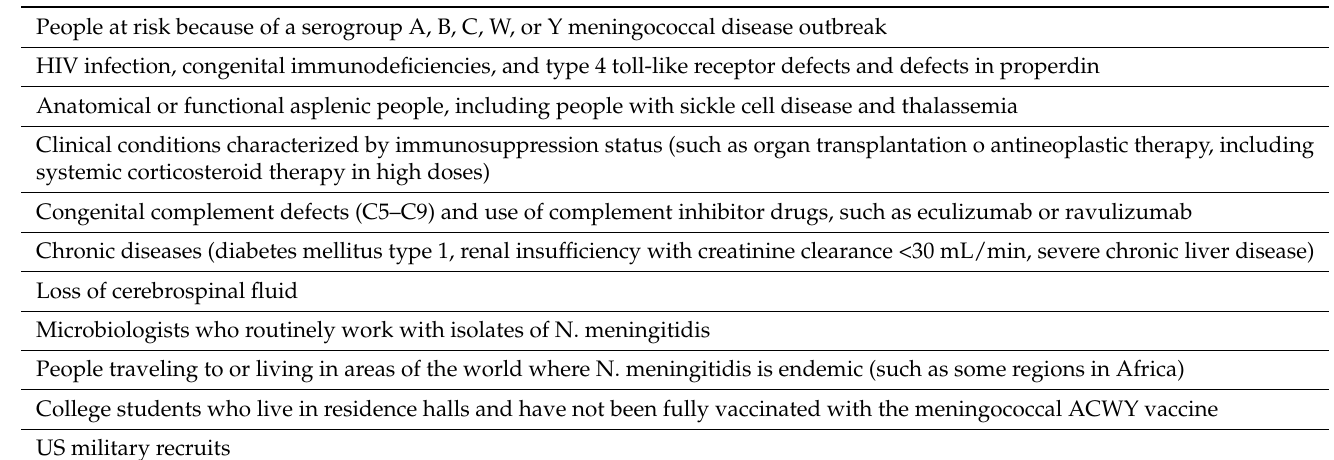
Table 2. People at increased risk of meningococcal